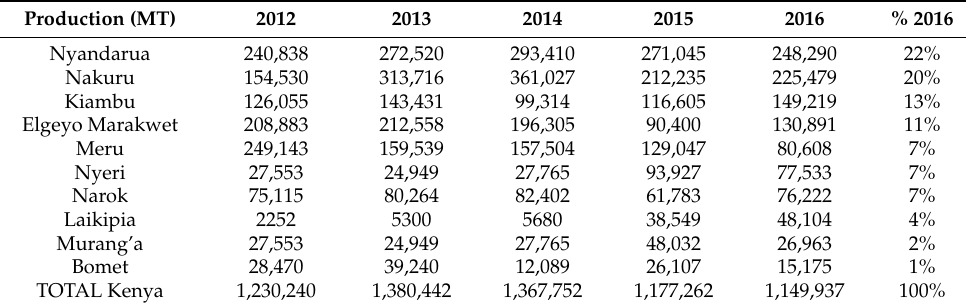
Table 1. Ware Potato Production in Metric Tons in Kenya per County (2016).